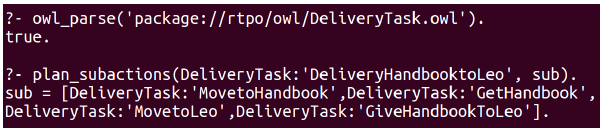
Figure 17. The specific implementation process of study case on TurtleBot3.